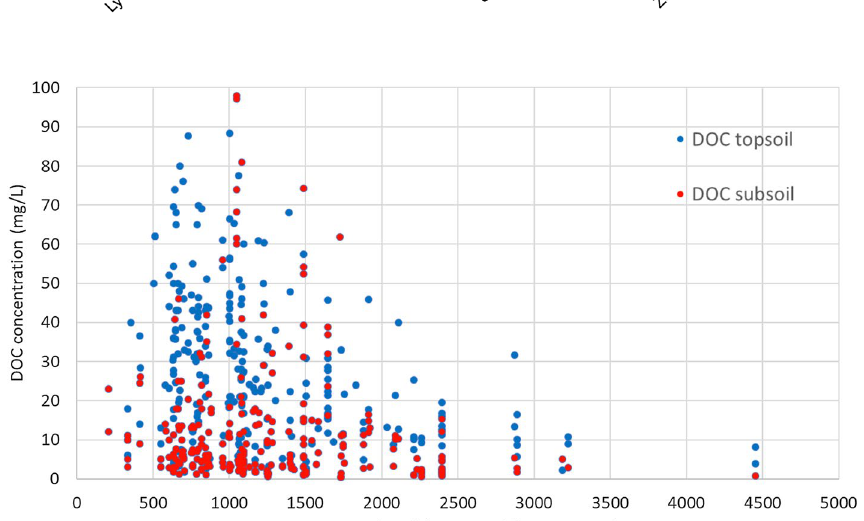
Fig. 3 Top and subsoil DOC concentration (mg C L −1 ) data distributed per measuring method (n = 550). Boxplot bars are medians. Whiskers extend up to 1.5 times the interquar- tile range (IQR) from the lower and upper quartile, unless exceeding the minimum or maximum. Circles are values exceeding the whiskers. Two subsoil values (up to 372 mg C L −1 ) from Histosols are not shown, but included in the distribution. ’Passive device’ is